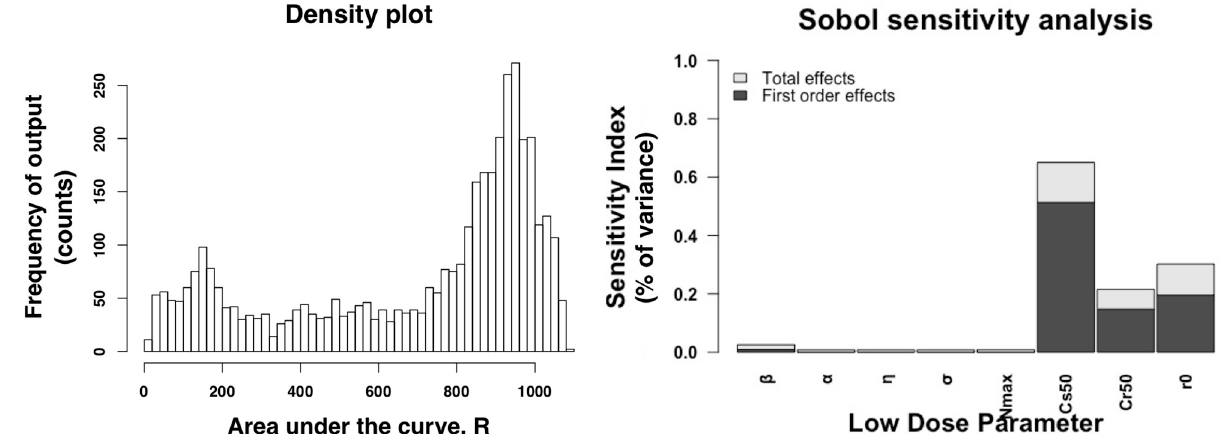
Fig 7. Low dose sensitivity analysis. Sobol sensitivity analysis results of the low dose regime. The left panel is a histogram of the output variable of the sensitivity analysis, the area under the curve of the bacteria above the ECOFF, R . The right panel is the sensitivity index for each parameters. The first order effects measures varying the parameter alone but averaged across all of the other variations while the total effect measures the effect of varying the parameters including variance caused by the parameters interactions.